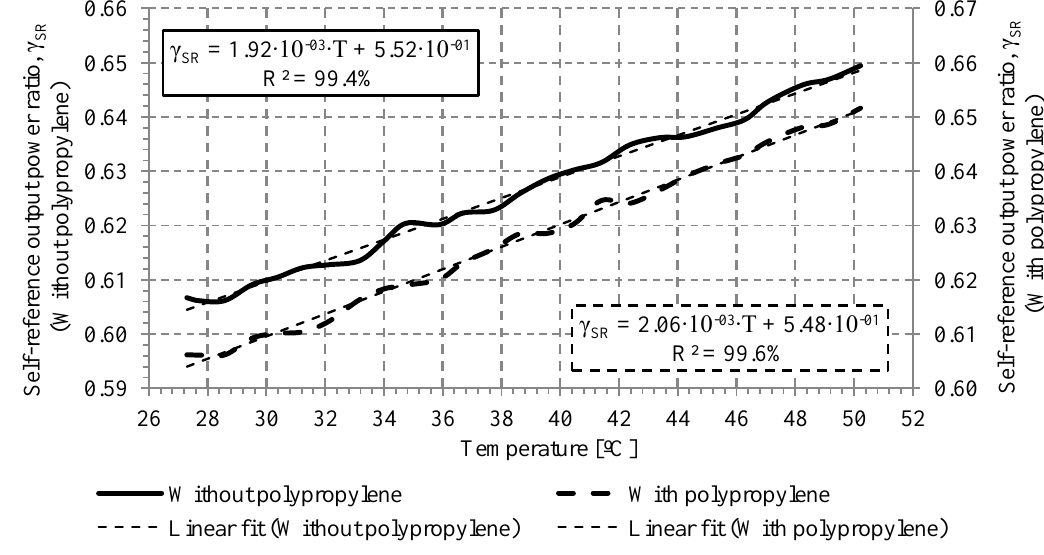
Figure 9. Calibration curves for a sensor with no contact and in contact with the metallic surface of the hot